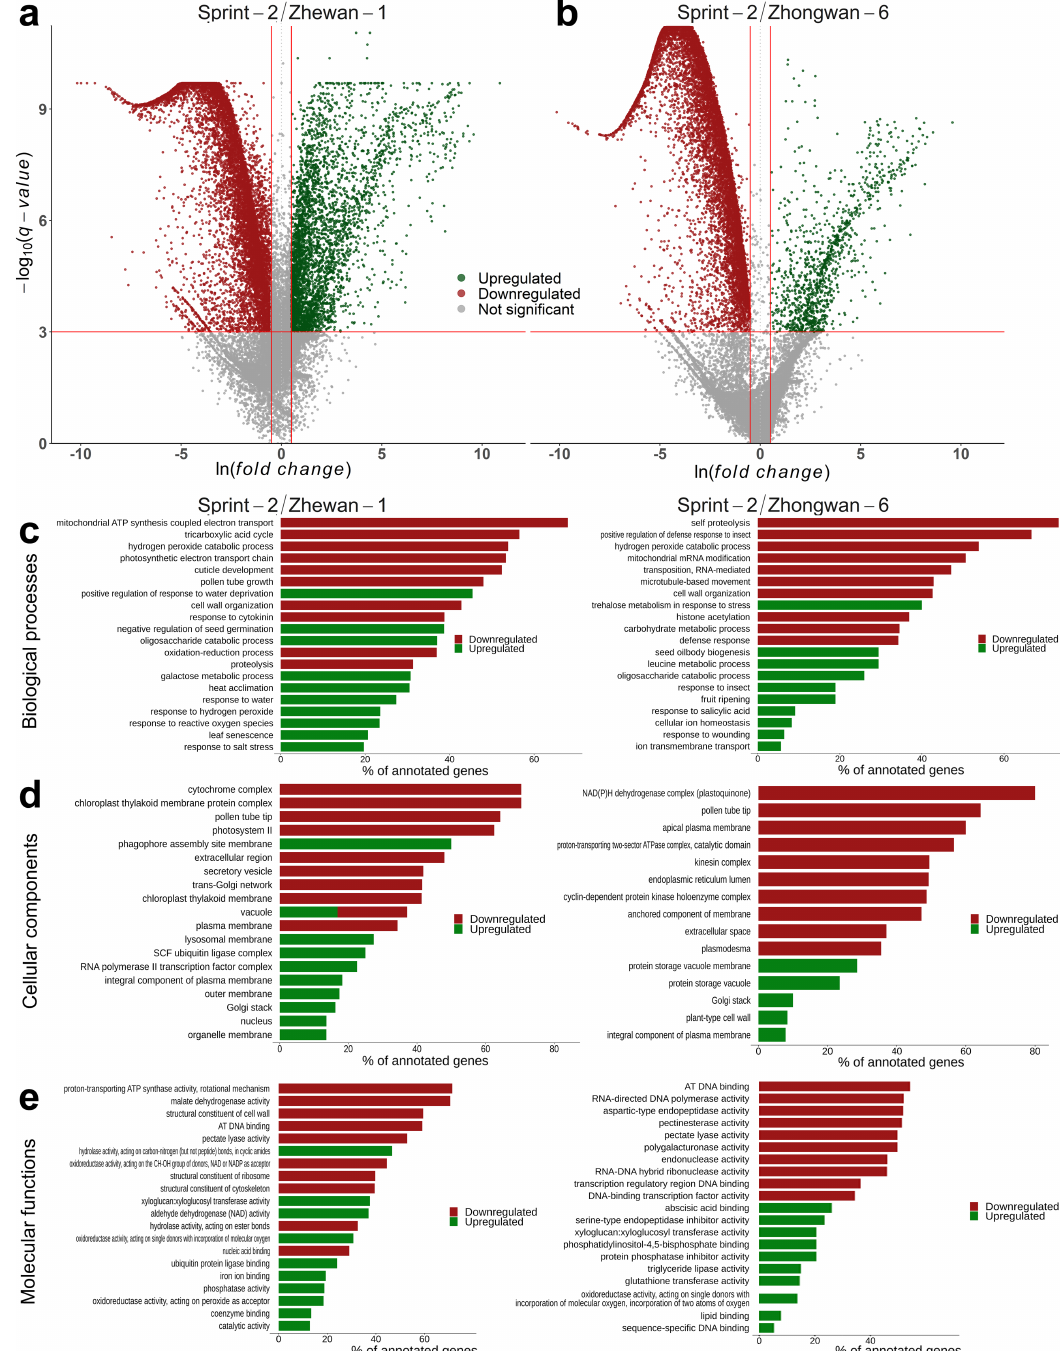
Figure 5. Di ff erential expression in 10 DAP seeds of Zhewan-1 and Zhongwan-6 pea cultivars compared to Sprint-2. ( a , b ) Volcano plots demonstrating di ff erentially expressed transcripts in Zhewan-1 and Zhongwan-6, respectively, compared to Sprint-2. Plotted on the x -axis is the ln fold di ff erence between Sprint-2 and the corresponding cultivar. Plotted on the y -axis is the − log 10 (q-value). Genes whose expression changes are nonsignificant are shown in gray below the red line, while significant di ff erentially expressed genes (FDR < 0.001) are divided into upregulated (green dots) and downregulated (red dots) genes. ( c – e ) Visualization of terms over-represented among di ff erentially expressed genes from Biological Process, Cellular Component, and Molecular Function aspects, respectively. The first ten categories have been chosen per aspect and arranged by the adjusted q-value. Bars are ranked according to the number of transcripts from the respective category being di ff erentially